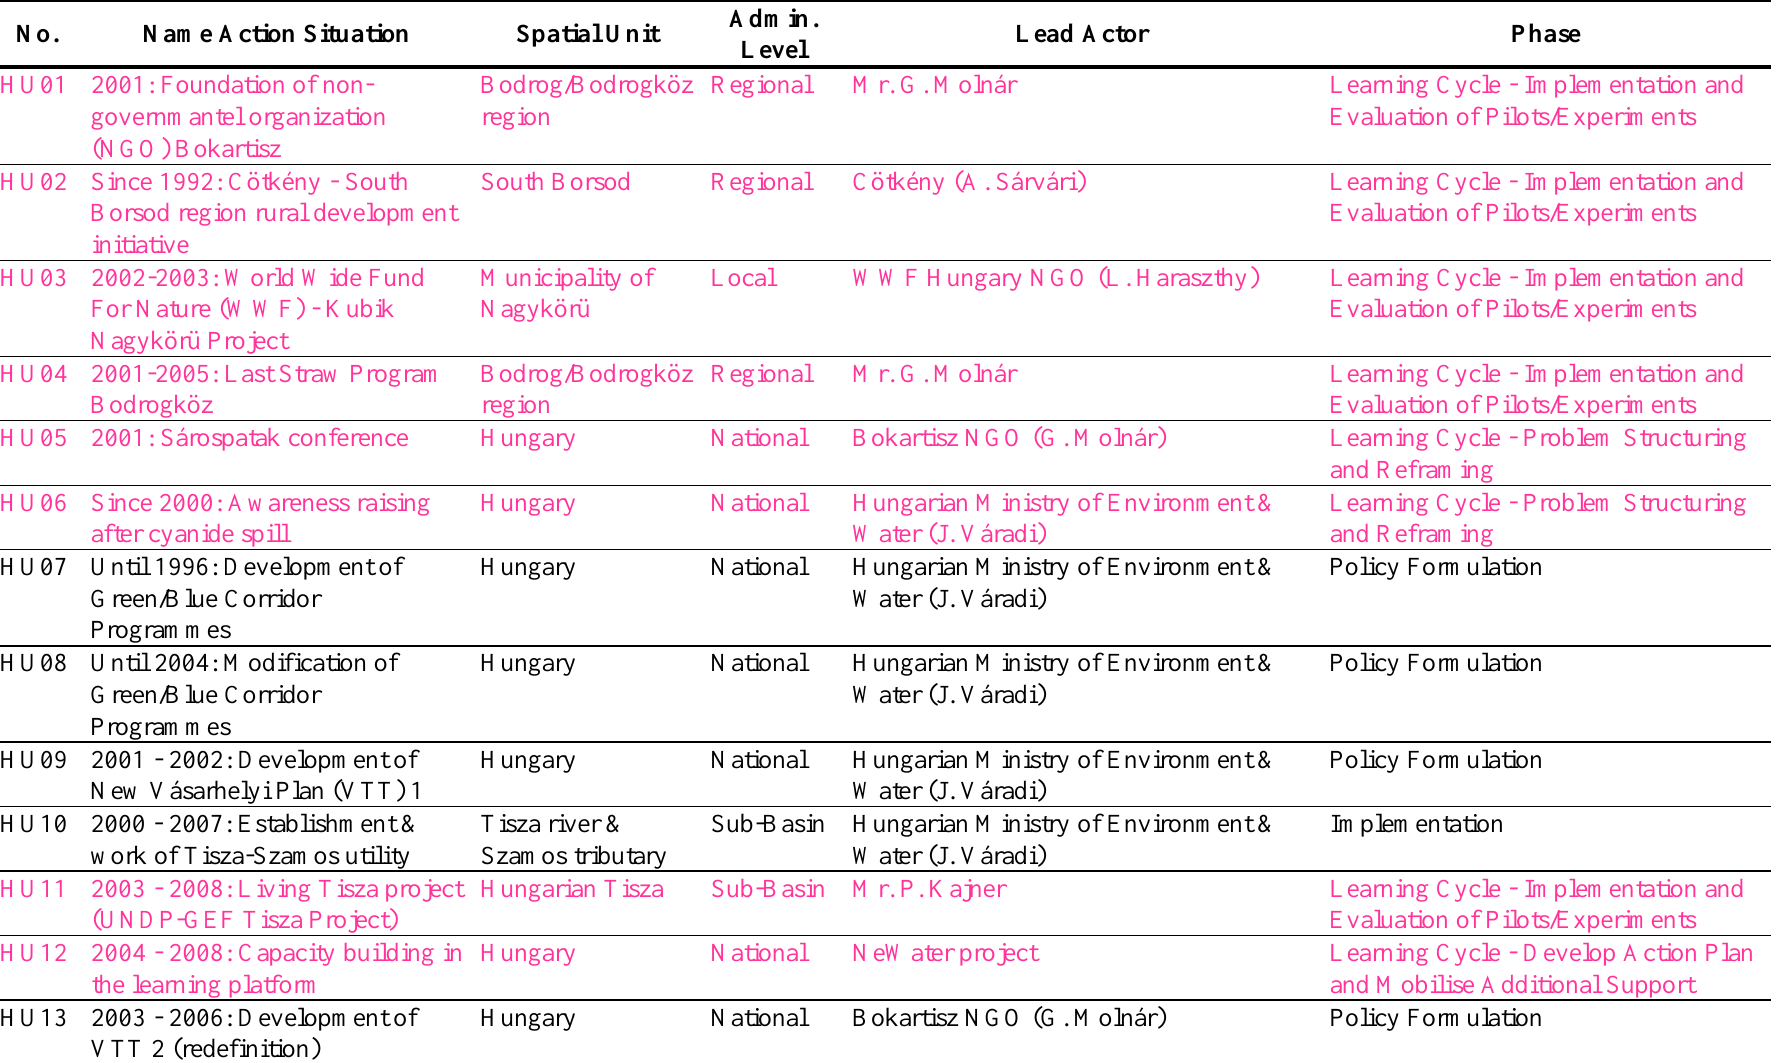
Table A2. Action Situations for the Tisza Hungary (HU, learning ASs in